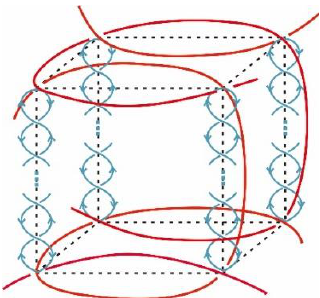
Figure 8. An example of knots constructed from two parts, in which some crossings (red curves) are mapped from spins in a unit cell (black dashed lines) of the 3D Ising lattice, and some crossings (blue curves) are attached braids that come from the nontrivial topological structure, originating from the nonlinear terms of the transfer matrices.